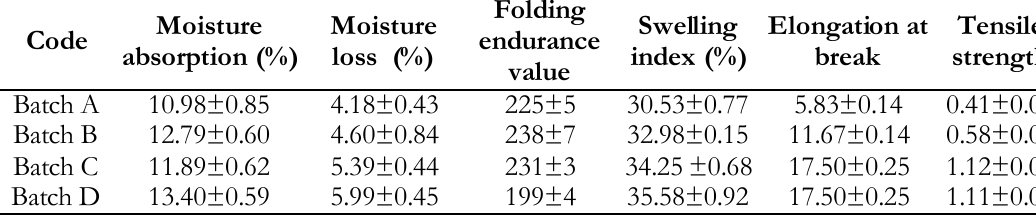
Table III. Evaluation of ocular inserts Code